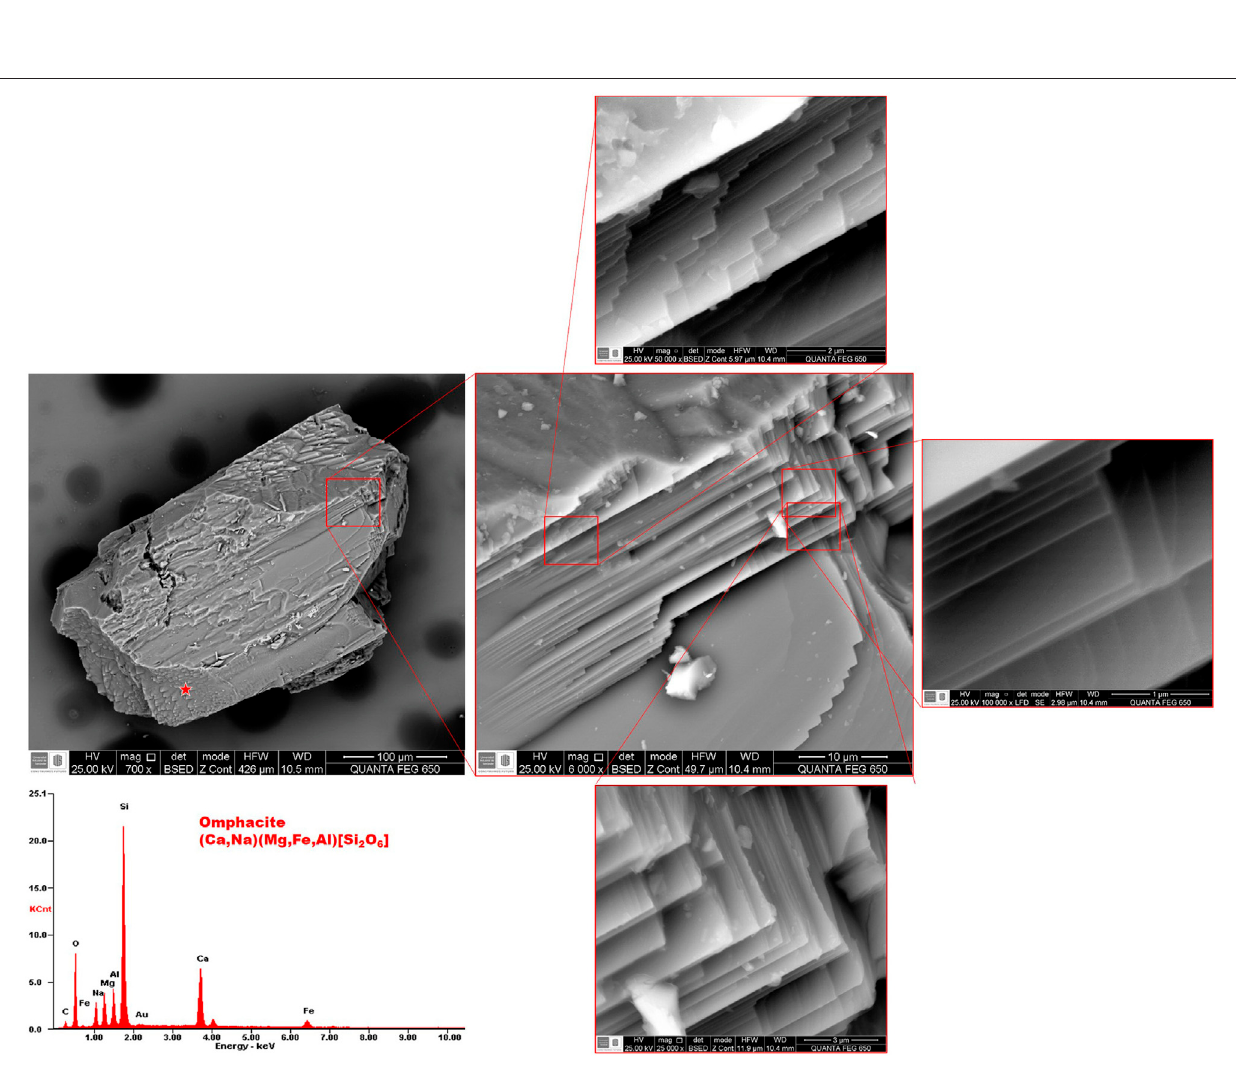
Frontiers in Earth Science |